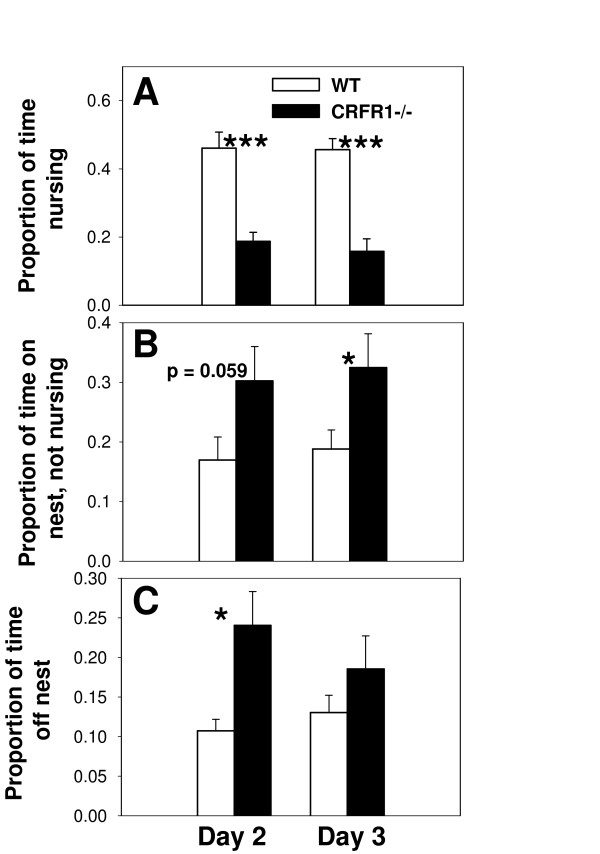
Analysis of nursing related behaviors in WT and CRFR1-/- mice. On postpartum Days 2 and 3, CRFR1-/- females exhibited significant deficits in proportion of time nursing relative to WT mice (A). Further, even while on the nest, CRFR1-/- mice spent less proportion of time nursing pups relative to WT mice in Day 3 (B). CRFR1-/- mice spent significantly more time away from the nest on postpartum Day 2 relative to WT mice, but differences between groups on Day 3 did not reach significance (C). Bars represent means ± SE. White bars indicate WT mice and black bars indicate CRFR1-/- mice. * = p < 0.05; *** = p < 0.001; one-way ANOVA (A) and (B) and one-way ANOVA on ranks for (C).